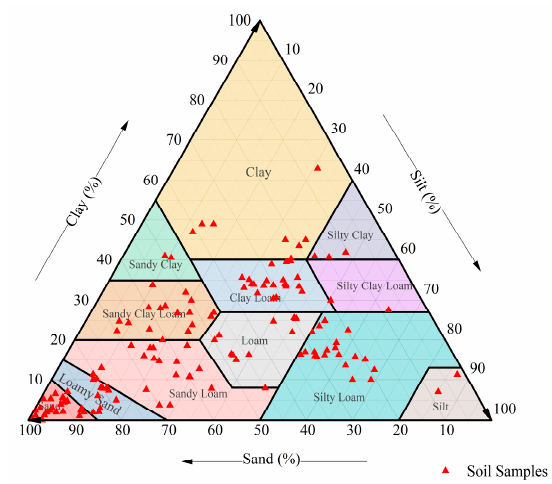
Figure 1. Textural distribution of the 144 soil samples.